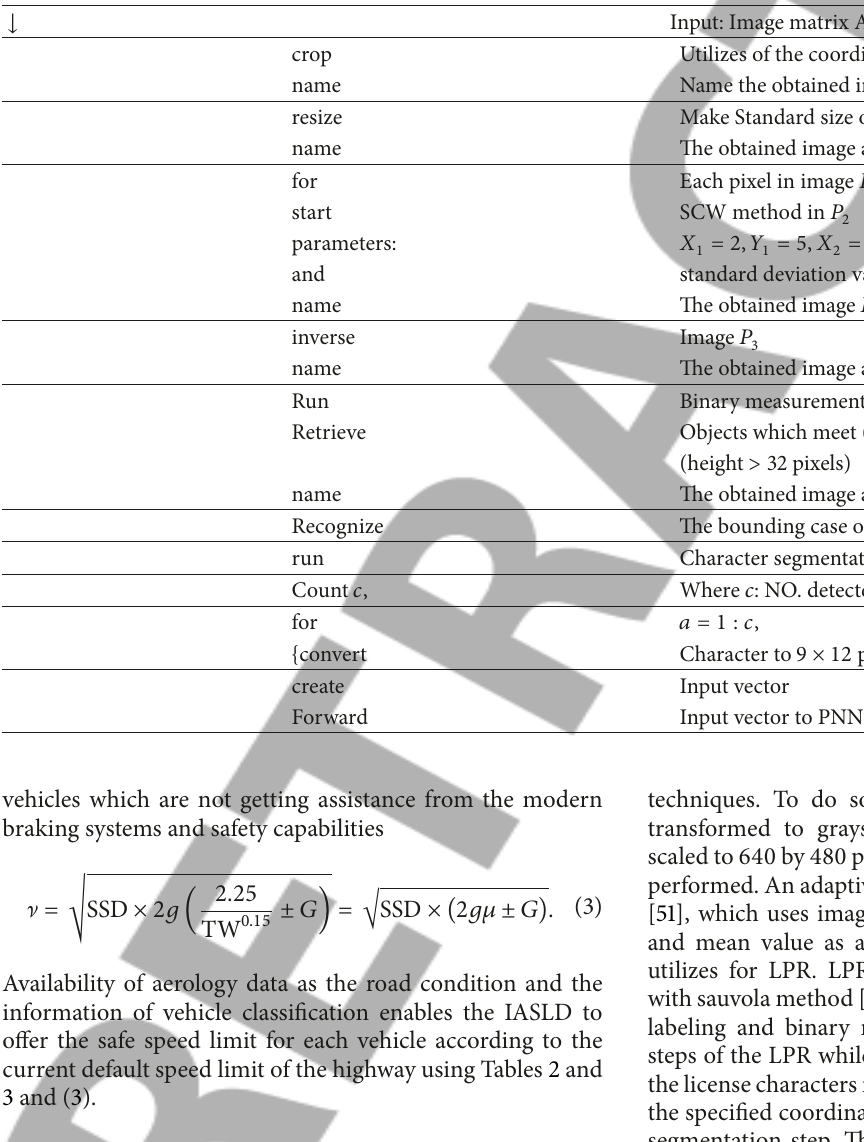
Table 4: Plate processing and character